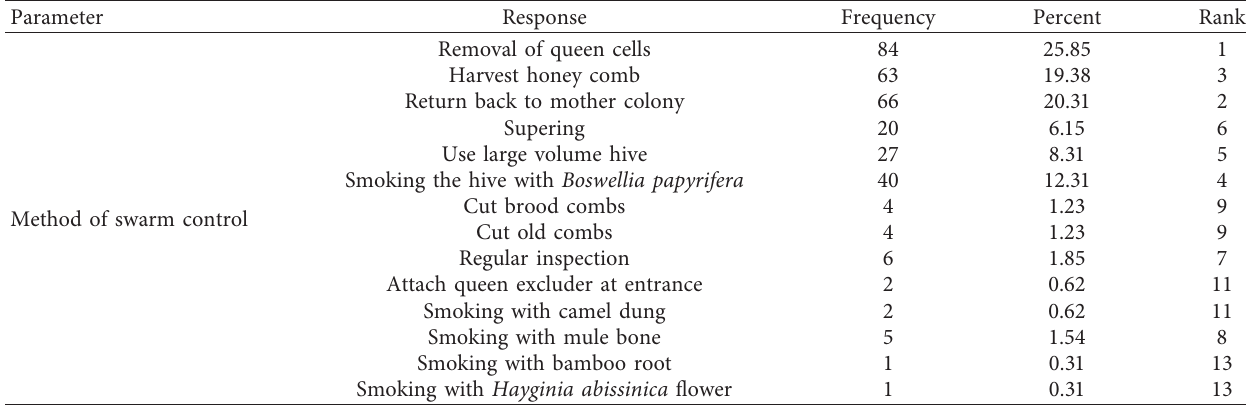
Table 10: Method of swarm control.